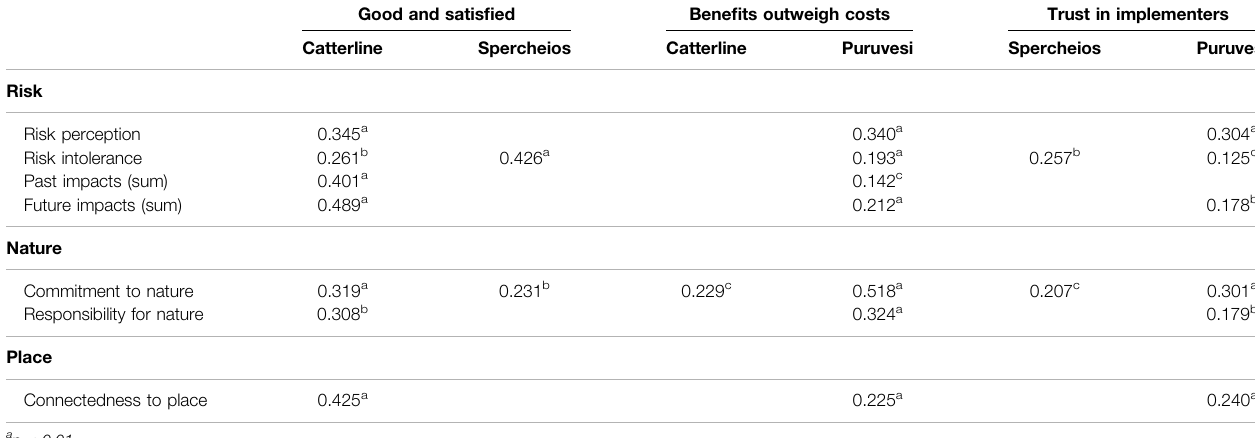
TABLE 4 | Spearman ’ s rho ( ρ ) correlation coef fi cients of attitudinal acceptance factors and risk, nature, and place survey variables in the three study sites. Only correlations signi fi cant to at least p < 0.10 are shown.